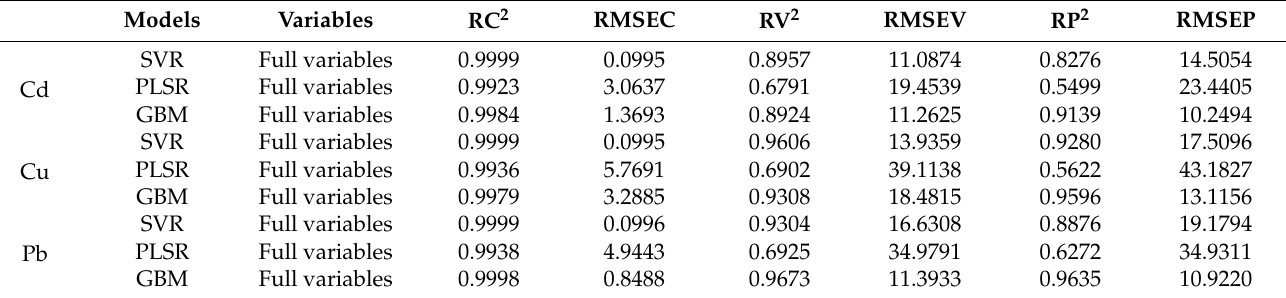
Table 2. Prediction results of the different models using full variables.